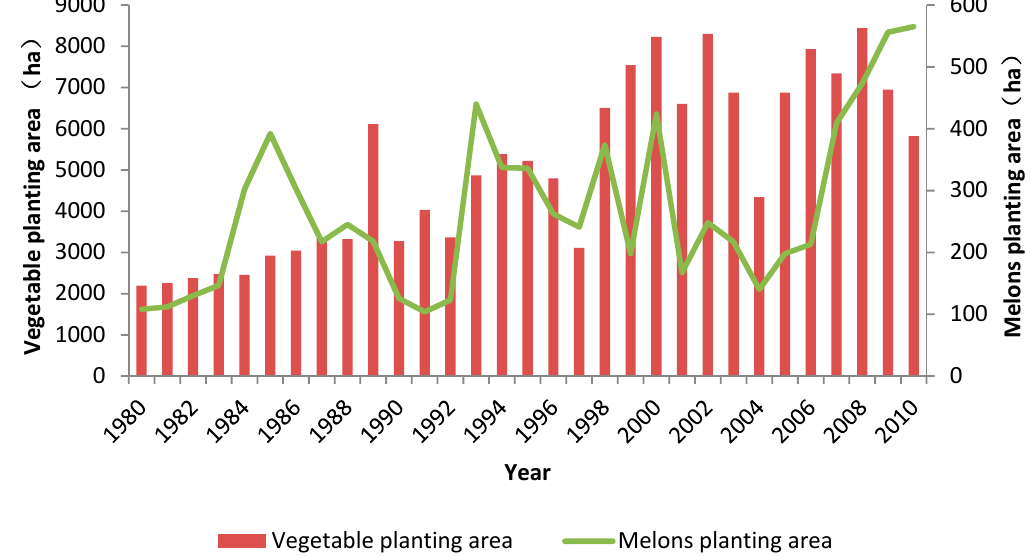
Figure 5. Change of economic crop planting area from 1980 to 2010.